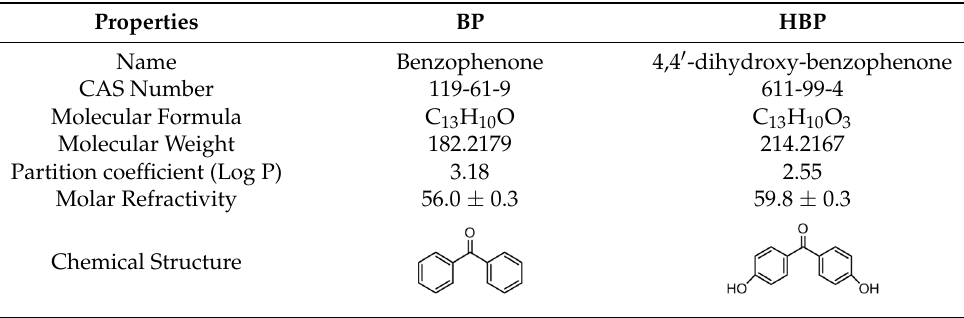
Table 1. Properties of benzophenone (BP) and 4,4 ′ -dihydroxy-benzophenone (HBP).